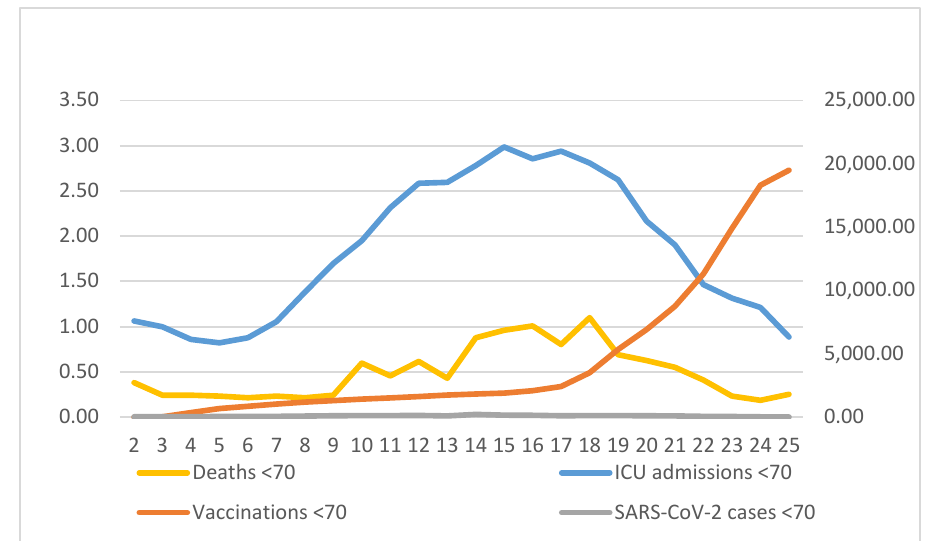
Figure 5. Average of vaccinations, weekly SARS-CoV-2 cases, ICU admissions and deaths for subjects <70 years. Data are expressed per 100,000 population. The left y axis corresponds to ICU admissions and deaths. The right y axis refers to vaccinations and SARS-CoV-2 cases.